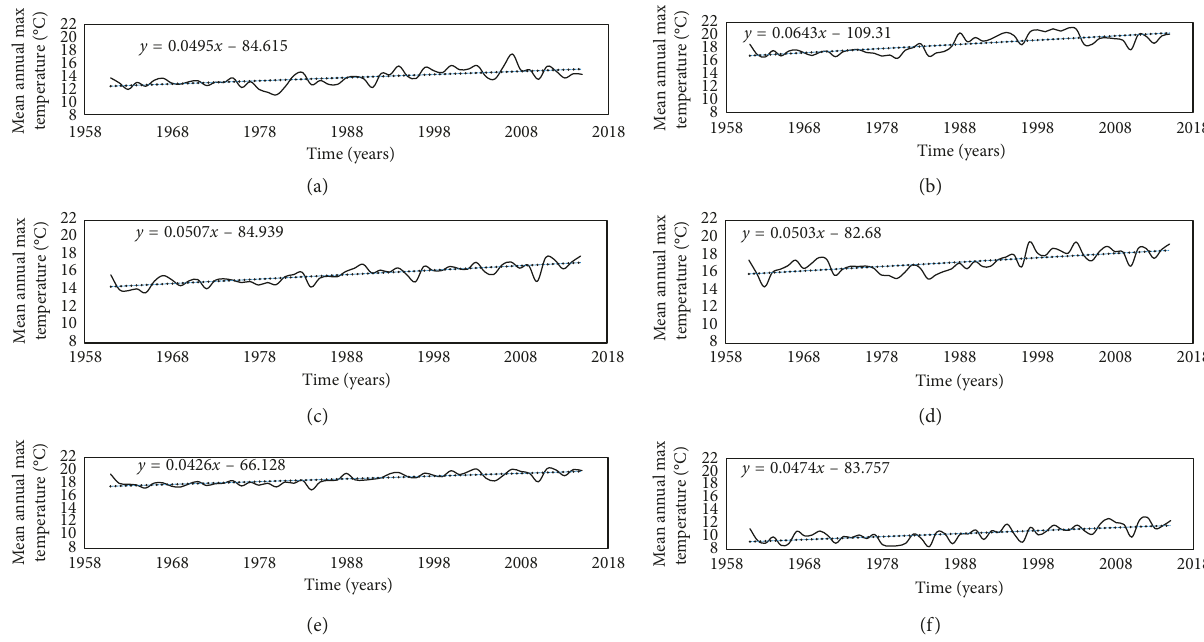
Figure 7: Temporal variation and trend line of annual maximum TTfor six meteorological stations during the period 1961–2015. (a) Verghereto, (b) Reggio Emilia, (c) Bedonia, (d) Vigoleno, (e) Conselice, and (f) Abetone. For the locations of the weather stations, refer to Figure 1.